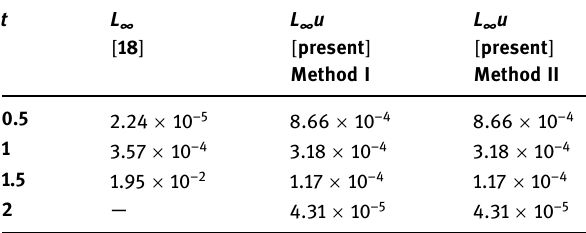
Table 9: Comparison of maximum absolute error at di ff erent time levels for = α 20 , = β 10 , = N 101 , and = τ 0.5 regarding Example 3